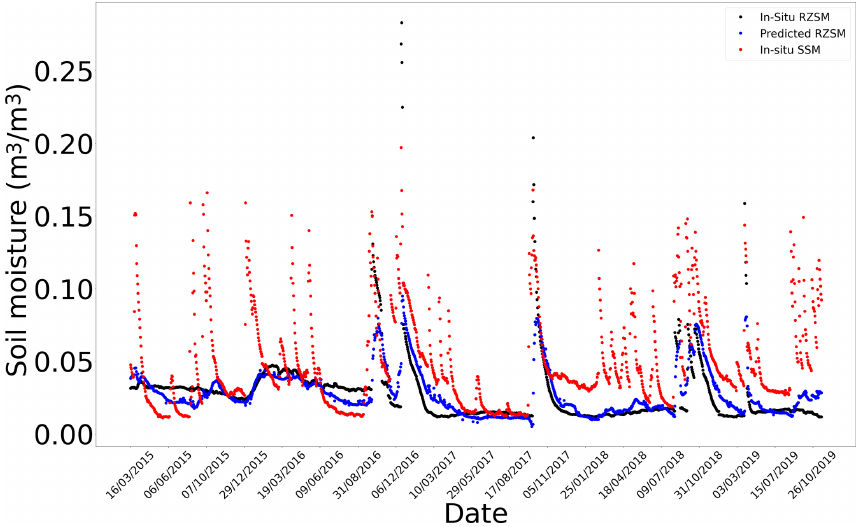
Figure G4. In situ SSM, in situ RZSM, and predicted RZSM series at station Barrouta_160 (Tunisia) with model ANN_SSM_NDVI_EVAP-